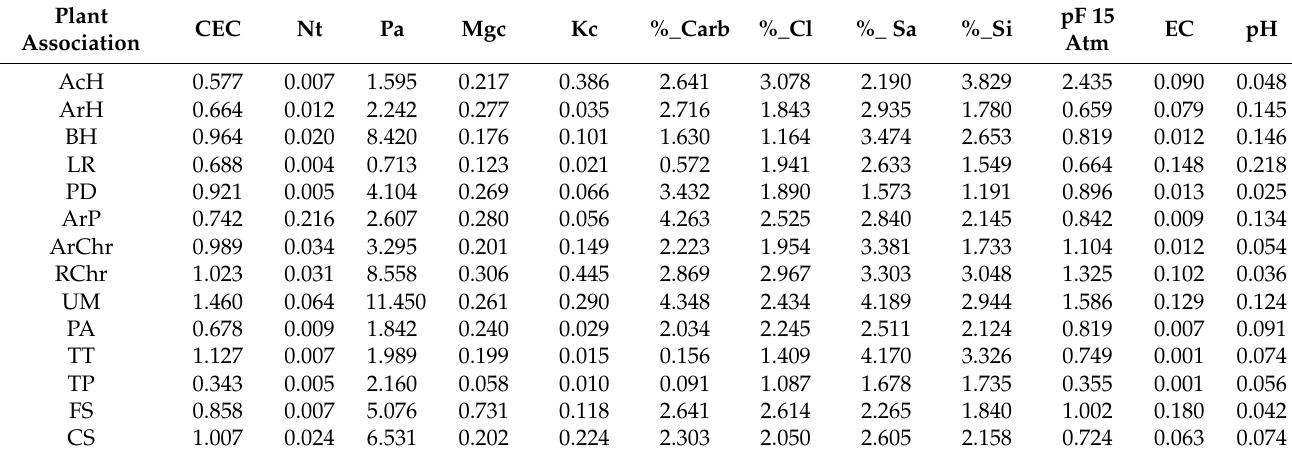
Table 2. Standard error for the edaphic parameters of the associations studied. CEC = cation-exchange capacity in cmol/kg; Nt = total nitrogen in %; Pa = assimilable phosphorous in ppm; Mgc = exchangeable magnesium in cmol/kg; Kc =